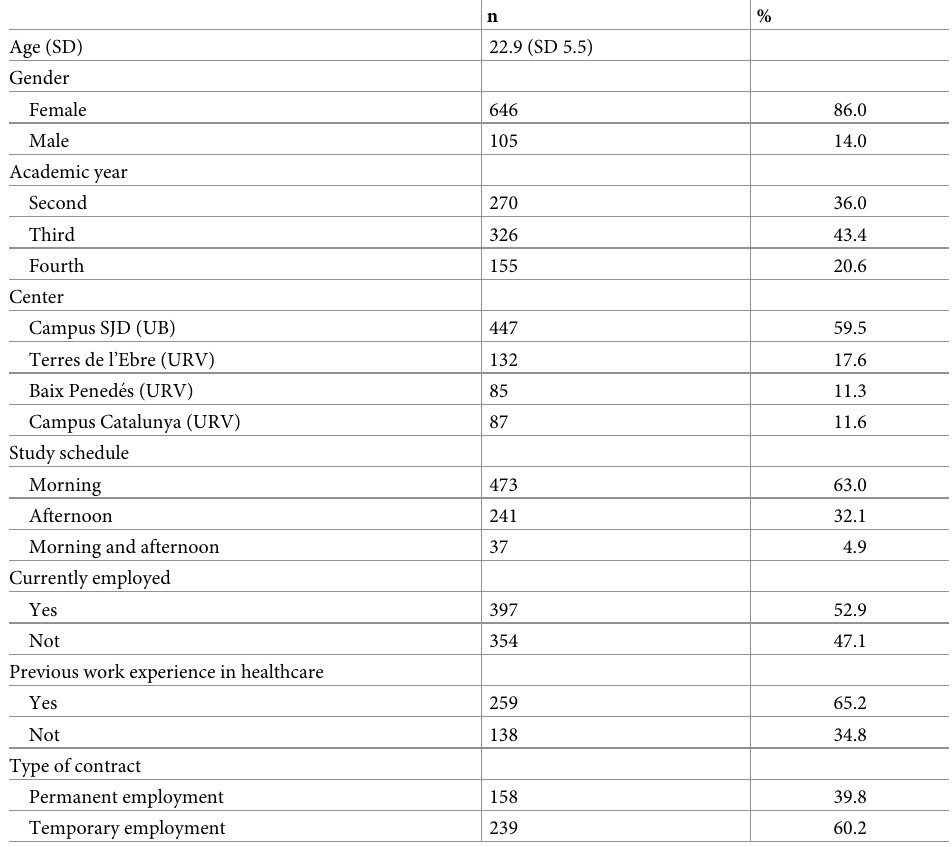
Table 2. Sociodemographic characteristics of the study